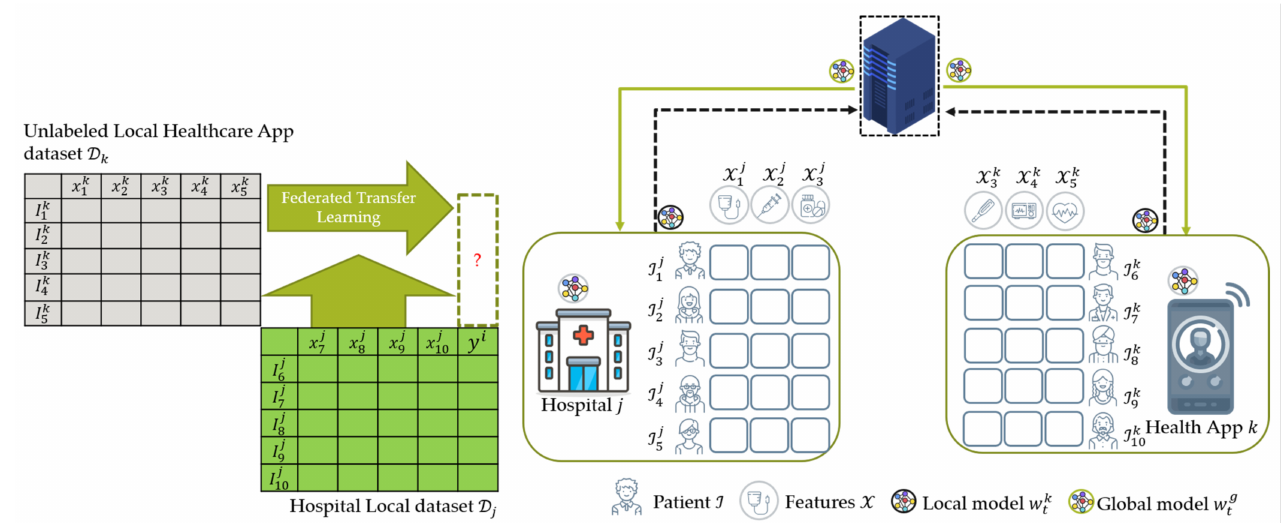
Figure 8. The typical medical data partitions scenario for federated transfer learning (FTL). One party is a medical institution, while the other is a healthcare application located in a different region. They share neither the patients’ index I j (cid:54) = I k nor features of medical diagnosis X j (cid:54) = X k